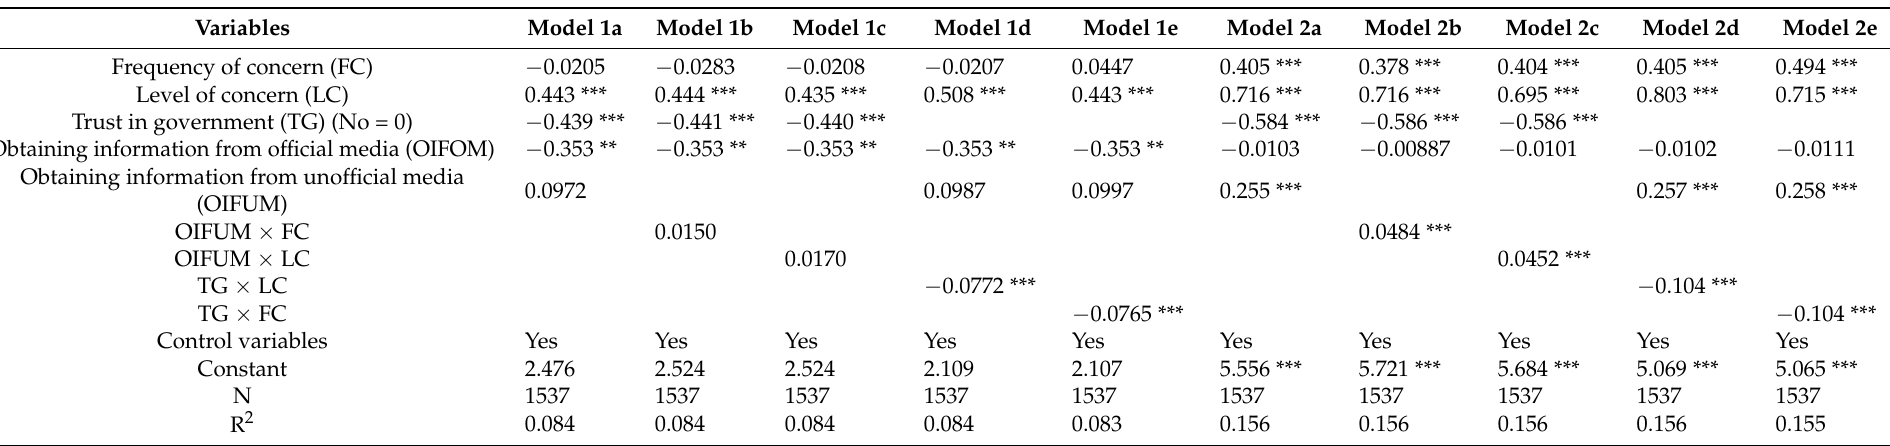
Table 3. Regression model of trust in government and obtaining information